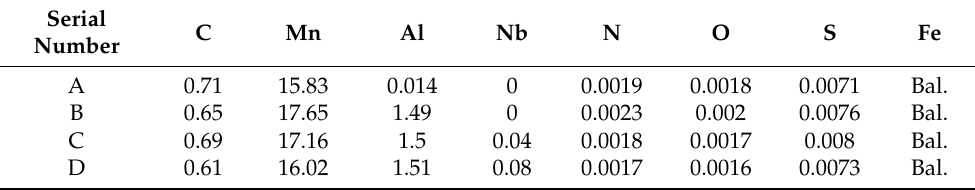
Table 1. Chemical composition of Fe-Mn-Al-C high manganese steel